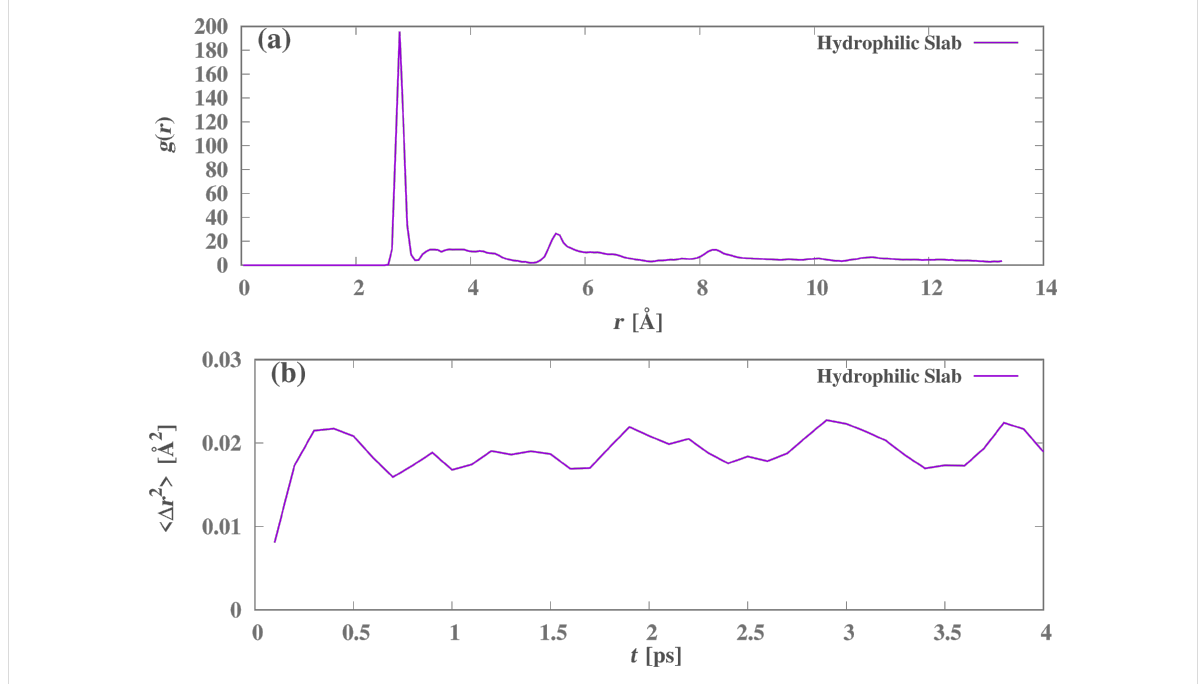
Figure 8: (a) Radial distribution function and (b) mean square displacement of the water molecules on the attractive slab at t = 0.5 ns and ε r = 1.1.